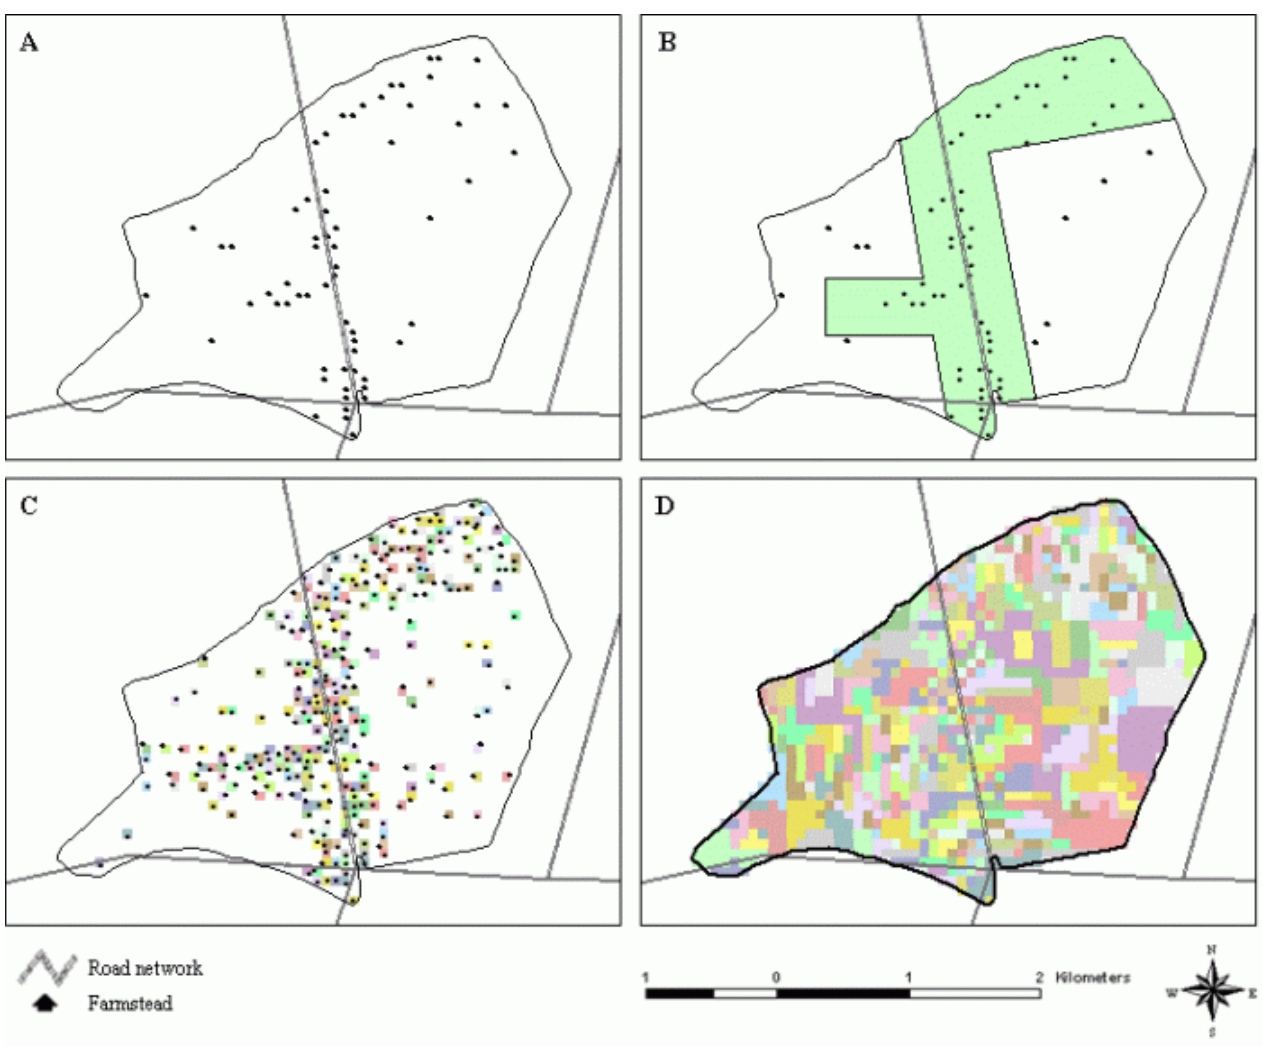
Fig. 2. Spatial generation of agent population and agricultural plots from a sample of farm